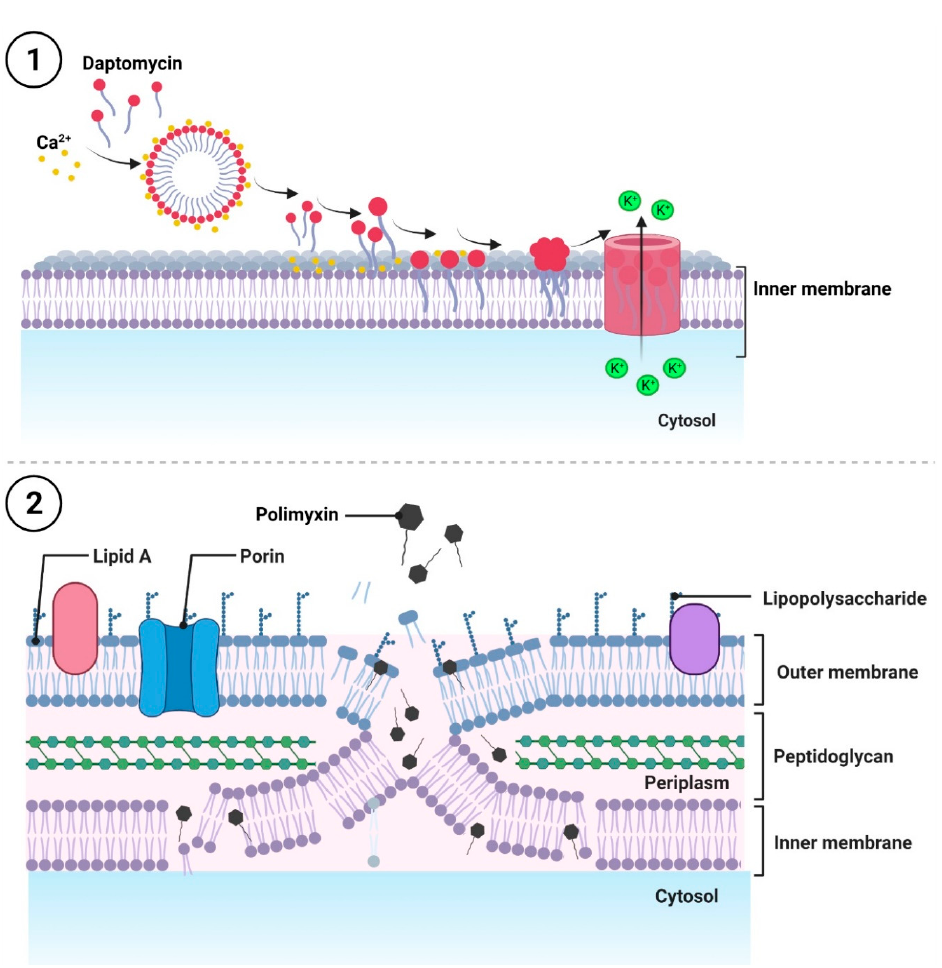
Figure 2. Mechanism of action of ( 1 ) the lipopeptide antibiotic daptomycin and ( 2 ) polymyxin. Figure created with Biorender.com.